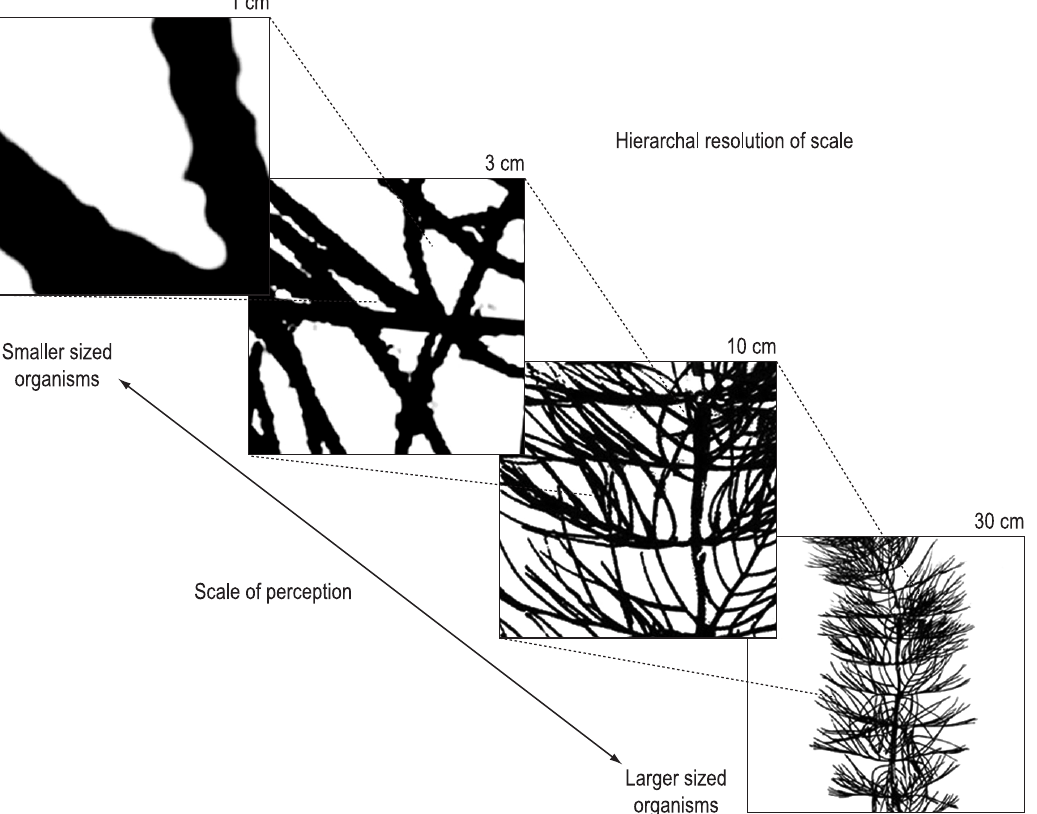
Figure 1. Different hierarchal scales within the aquatic macrophyte Myriophyllum spicatum showing different structural complexity at different scales. Based on Dibble et al.